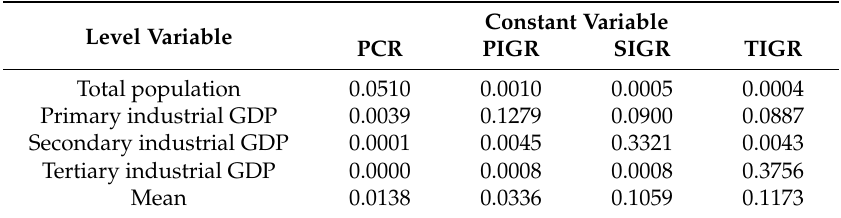
Table 3. Results of sensitivity analysis of the SD model (2011–2018).